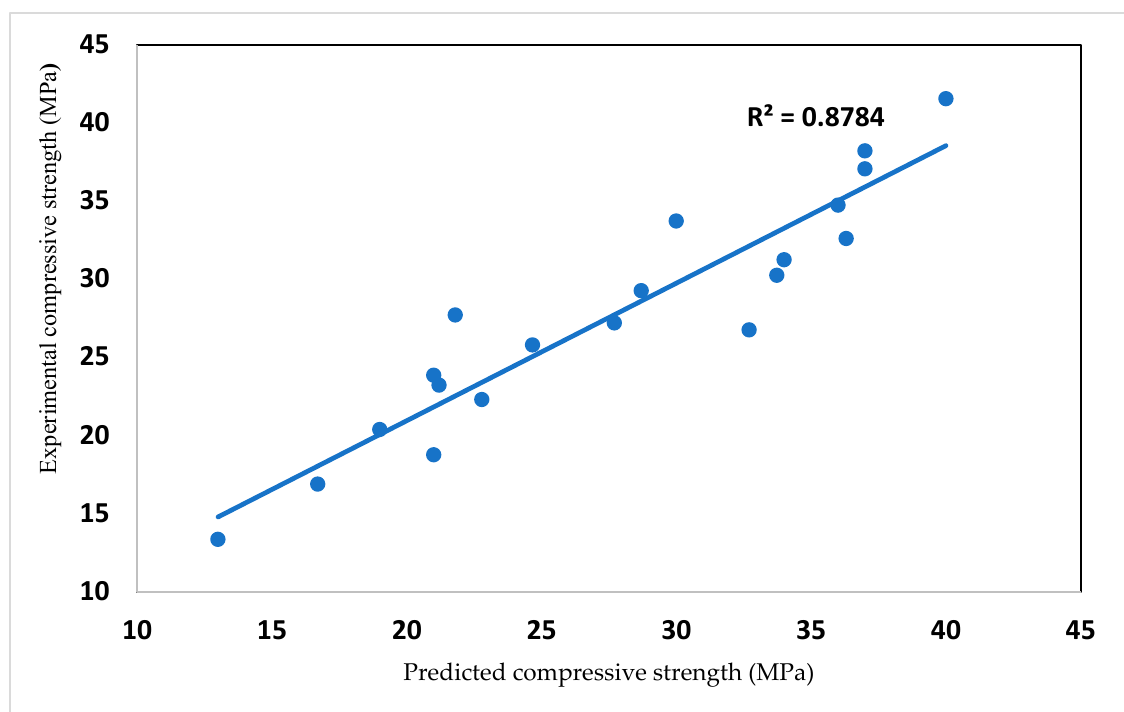
Figure 9. Experimental and predicted value of glass blended cement mortar .